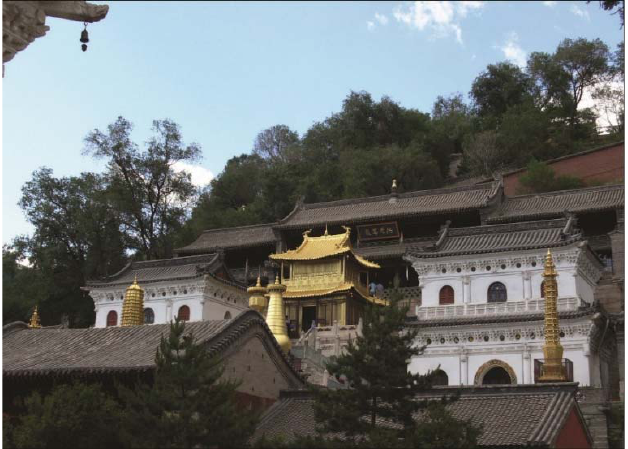
Figure 3. The copper hall and beamless halls of Xiantong Monastery at Mount Wutai, photograph by Jianwei Zhang in 2009 (J. Zhang 2015, p. 305, Figure 8).